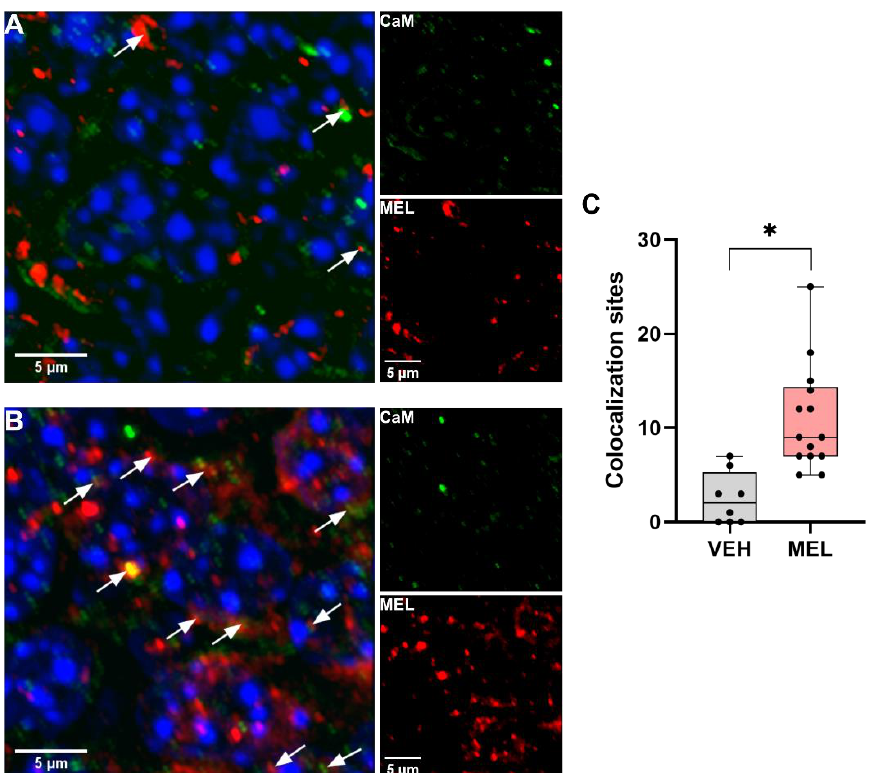
Figure 1. Colocalization of calmodulin and melatonin in the brain hippocampus. Mice were injected with the vehicle or 16 mg/kg melatonin (MEL) as described in Methods. Fixed brain hippocampal coronal slices were stained with specific anti-calmodulin and anti-melatonin antibodies by indirect immunofluorescence. ( A ) Representative image of the calmodulin (CaM) and MEL colocalization sites in mice treated with the vehicle (VEH) and ( B ) with MEL. Colocalization sites are identified with white arrows in the merged image. Single signals images for CaM (green) and MEL (red) are shown. Blue signals correspond to DAPI-stained cellular nuclei. ( C ) Colocalization sites in hippocampal zones were assessed in the slices of mice treated with the VEH or MEL. The graph shows data obtained from 2 mice injected with the VEH or MEL. Data were acquired from 2 near hippocampal zone slices, and per slice 2 random hippocampal images were taken. For MEL treatment, data were obtained from 3 mice from which 2 near hippocampal zone slices were obtained, and 2 random hippocampal images per slice were taken. Results were analyzed with a nested t test, * p < 0.05 was significant.